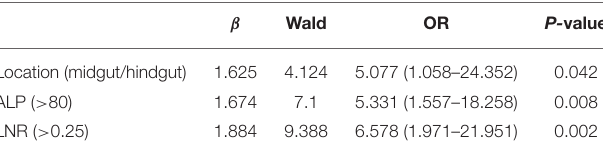
TABLE 3 | Multivariate analysis of the risk factors associated with early recurrence for